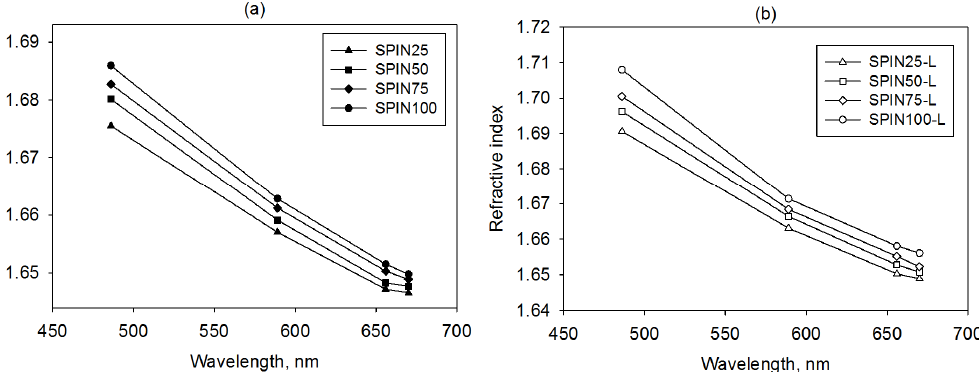
Figure 9. Light dispersion plots corresponding to ( a ) non-irradiated and ( b ) laser-exposed PI-based supramolecular systems.